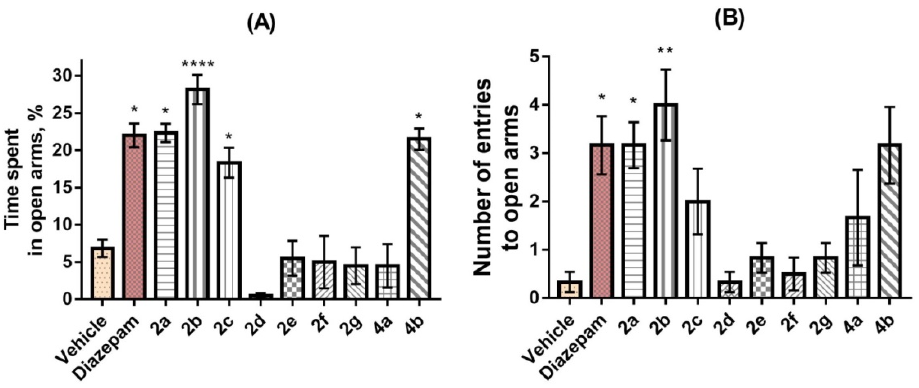
Figure 1. Anxiolytic activity of compounds in Elevated Plus Maze test in comparison with diazepam (1 mg/kg), mice, per oral administration, M ± SEM. Note: * Data are comparable to the control group (* p < 0.05, ** p < 0.001, **** p < 0.0001, Kruskal-Wallis test post-hoc Dunn’s test): ( A ) time spent in open arms (%); ( B ) number of entries to open arms.